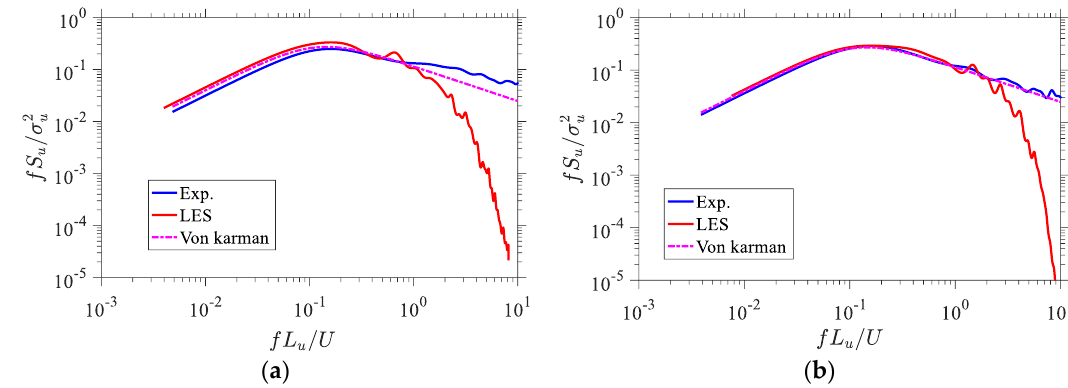
Figure 11. Stream-wise power spectral densities at ( a ) z = 1.5 H and ( b ) z = 10.5 H with immersing building models.